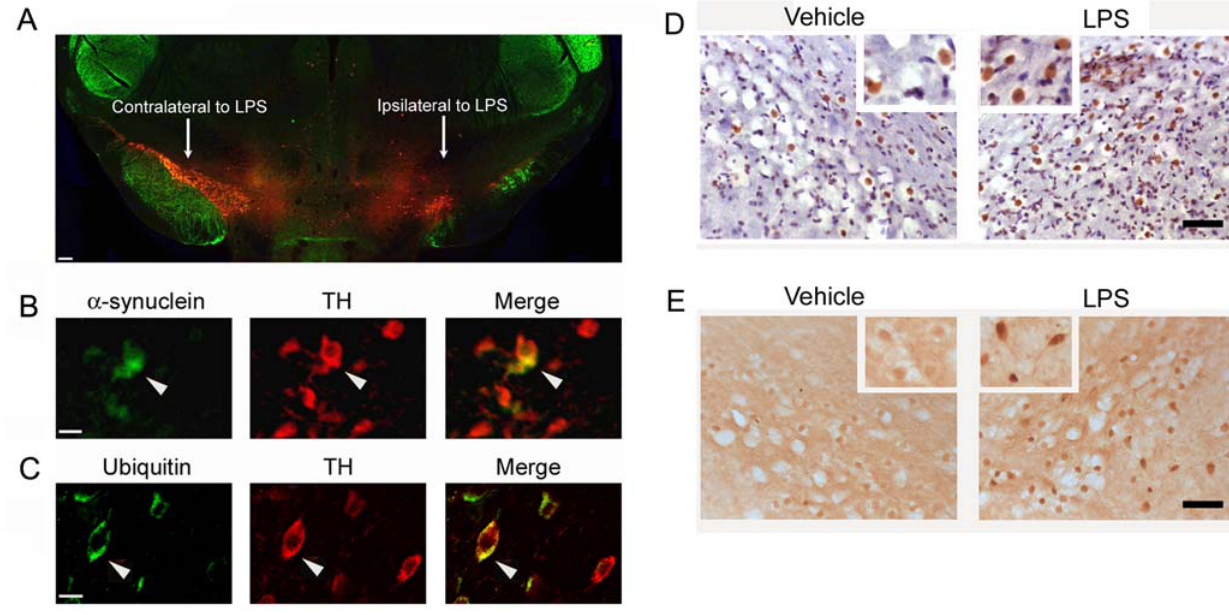
Figure 3. Cytoplasmic accumulation of a -synuclein and ubiquitin in the nigral TH-positive neurons at four weeks after intrastriatal LPS. (A) Photomicrograph of double immunofluorescent labeling with antibodies against TH (red) and a -synuclein (green) show that intrastriatal LPS mediates marked TH-positive cell loss in the substantia nigra ipsilateral to the injection. Scale bar: 100 m m. (B) High magnification images of the top photograph demonstrate that some of the spared TH-positive neurons have accumulated a -synuclein in their cytoplasm (arrow heads). Scale bar: 20 m m. (C) Immunofluorescent staining displays ubiquitin accumulation in the cytoplasm of the nigral TH-positive neurons (arrow heads). Scale bar: 20 m m. (D–E) Increase of proteinase K-resistant a -synuclein (D) or ubiquitin (E) in the substantia nigra after LPS injection. Scale bar: 50 m m.